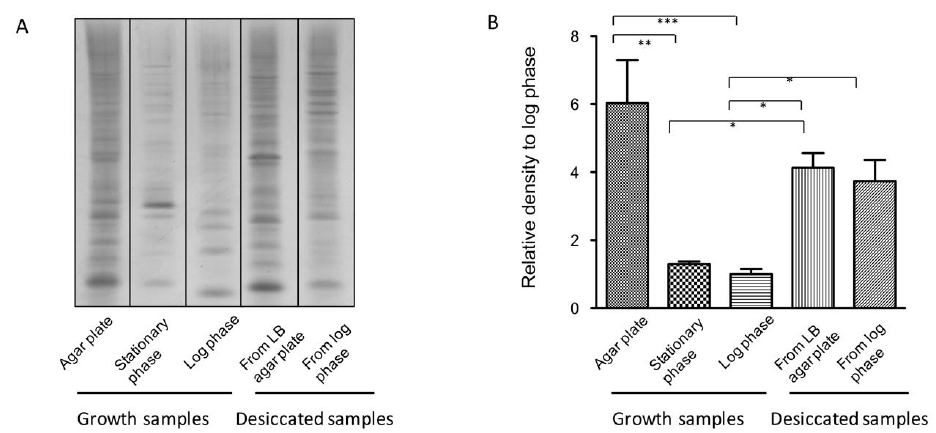
Figure 3. Protein aggregation levels in desiccated and growing bacteria. ( A ) Protein aggregates isolated from 17978 grown on LB agar plates or in liquid LB to stationary phase or log phase, or desiccated. The desiccated samples were grown either on LB agar plates or in liquid LB to log phase prior to desiccation. Aggregates were purified and normalized by total cellular protein concentration [46]. Samples in each panel were processed on the same gel. ( B ) Quantification of ( A ) normalized to the log phase growth sample. Mean area density with error bars (SEM) was obtained from 3 biological replicates. Area density comparisons were performed with Repeated Measures ANOVA followed